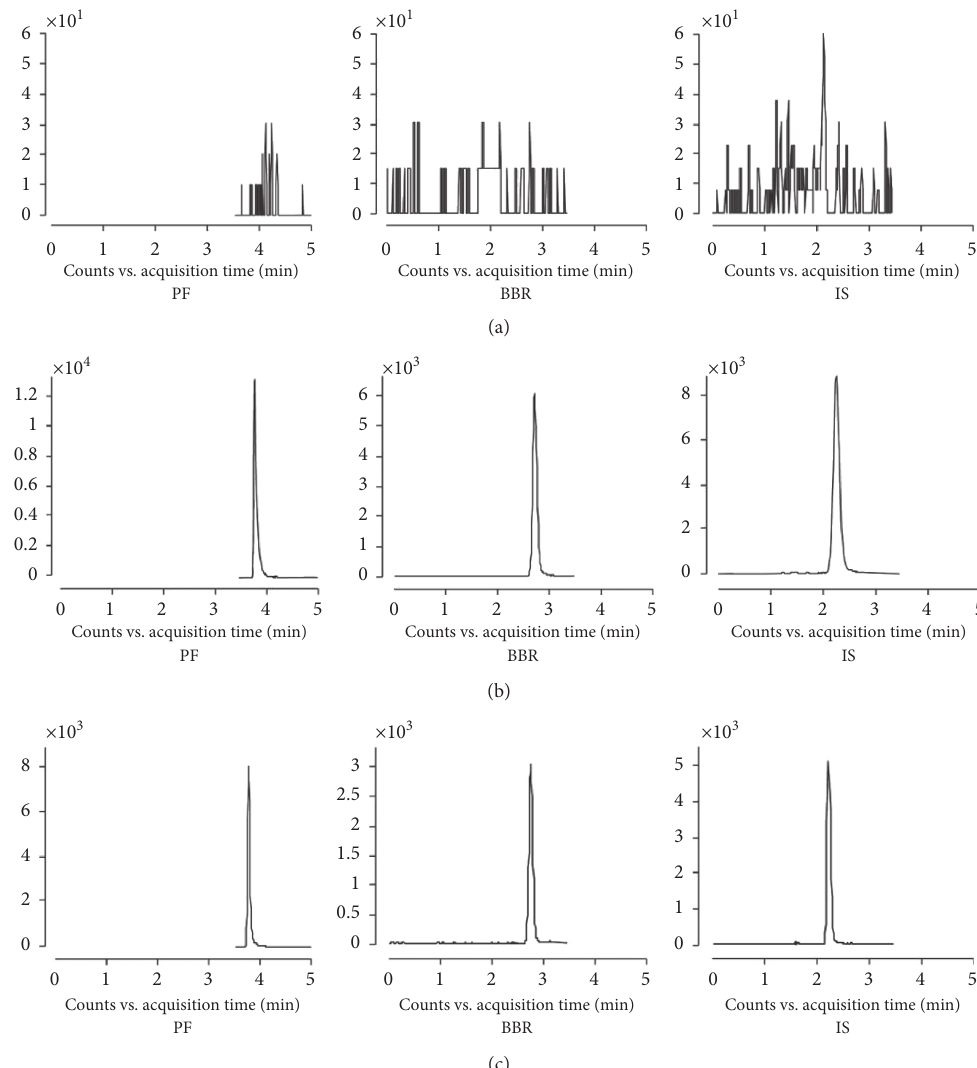
Figure 5: Representative multiple reaction monitoring (MRM) chromatograms of PF, BBR, and IS: (a) blank rat plasma, (b) blank rat plasma spiked with a standard solution, and (c) extracted plasma sample from a rat dosed with BSPs. Table 2: Matrix effect, extraction recovery, accuracy, and precision of PF, BBR, and IS in rat plasma. Spiked conc. Analyte